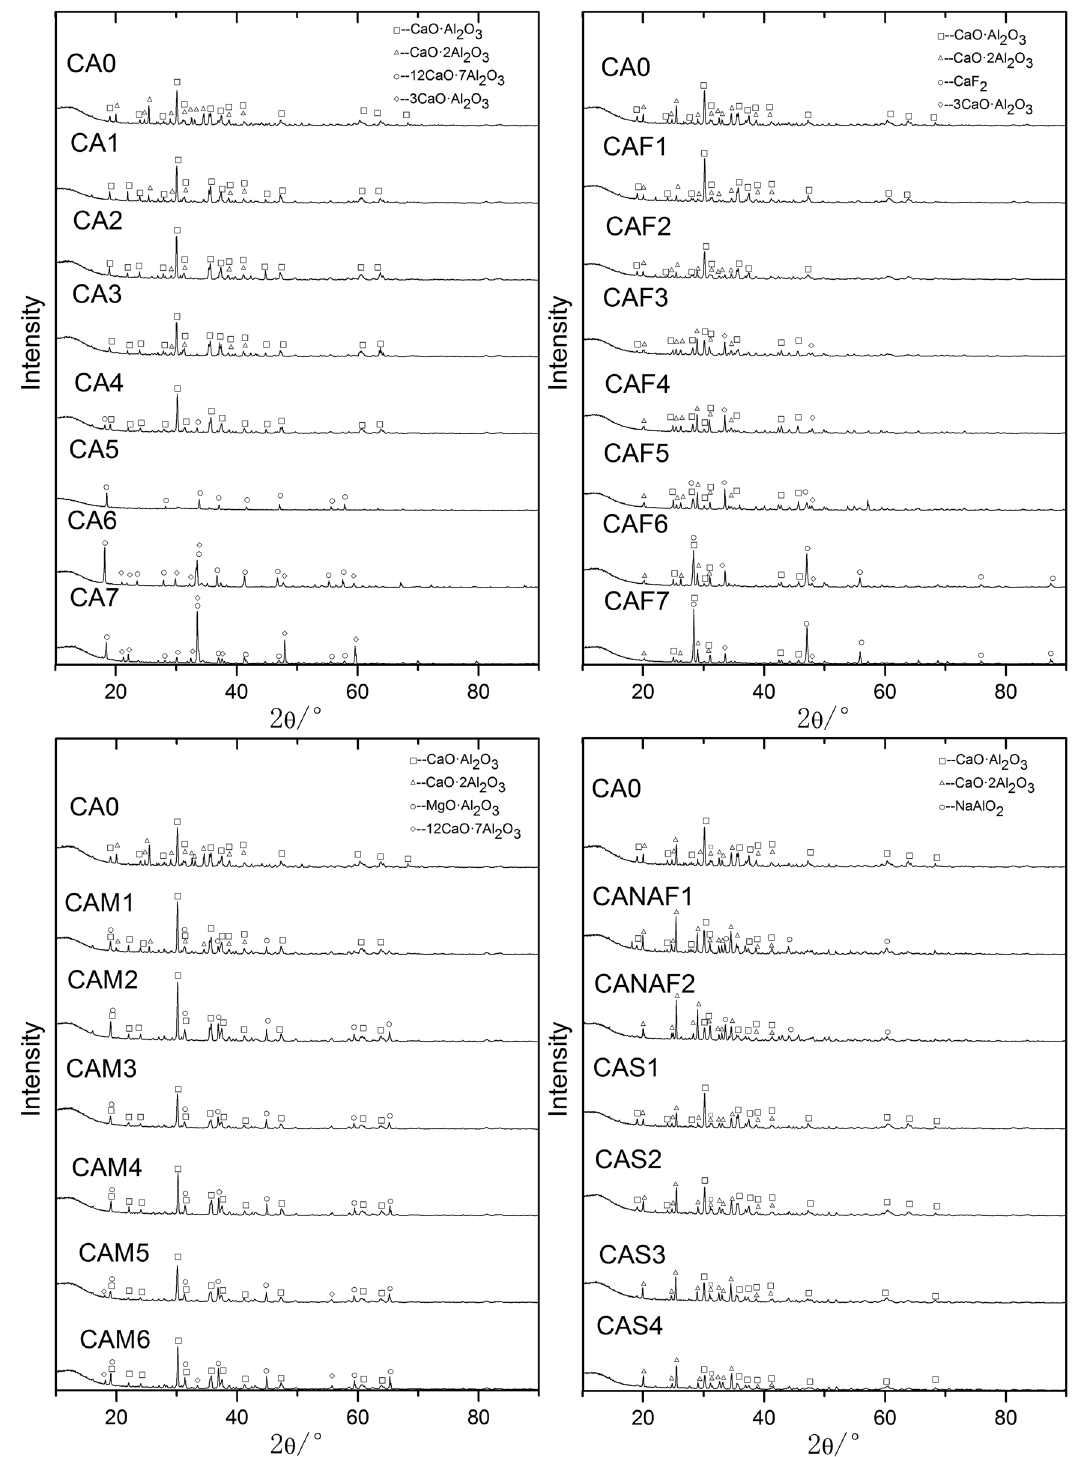
Figure 5: XRD analysis for di ff erent